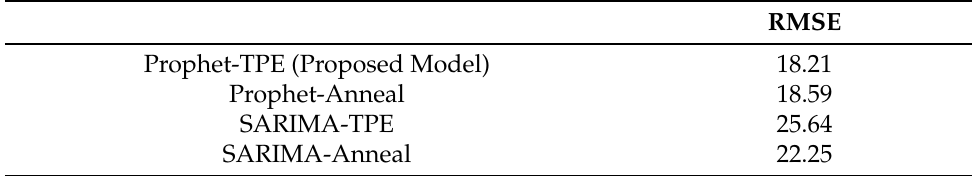
Table 3. Performance comparison of proposed Prophet-TPE model (state level) with other Prophet and SARIMA Bayesian optimized forecasting models.